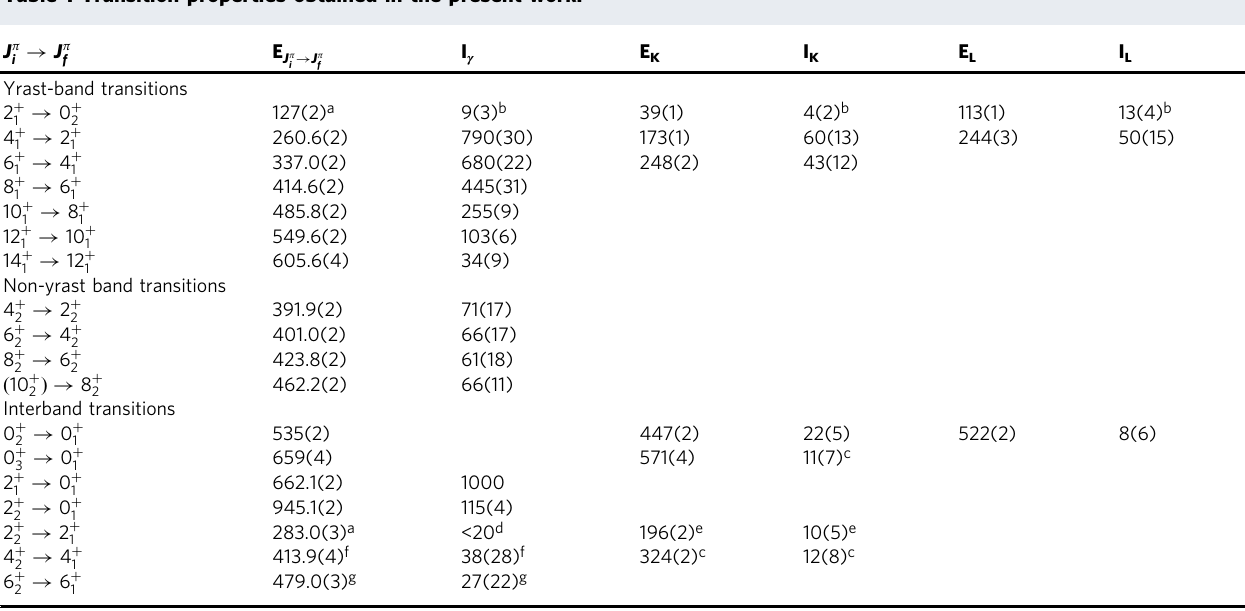
Table 1 Transition properties obtained in the present